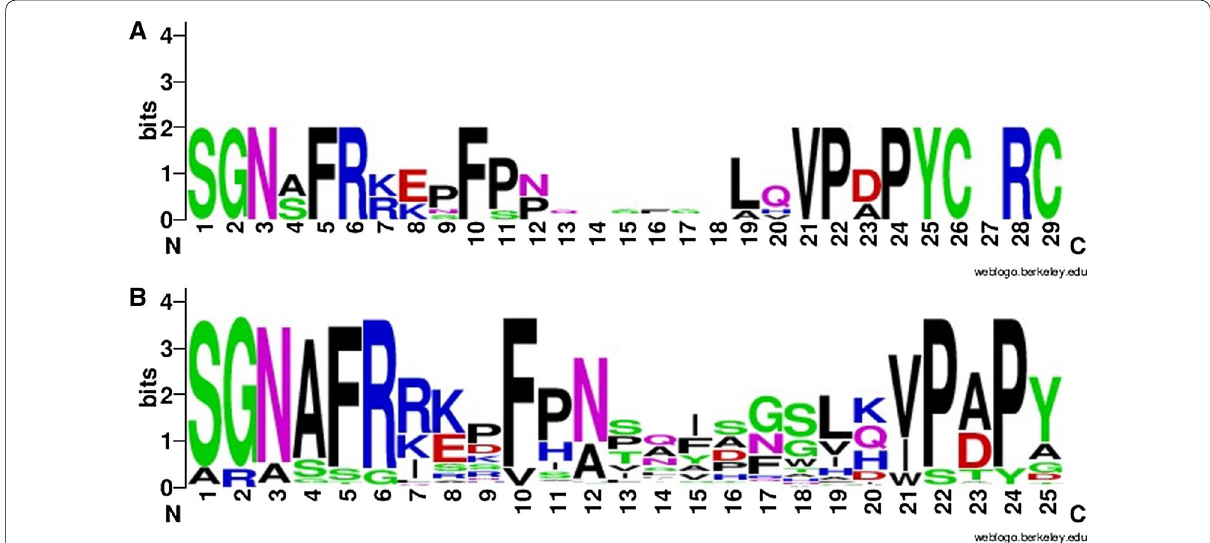
Fig. 6 A WebLogo sequence of all known azasugar producers (corresponding to amino acids 145–170 in B. velezensis FZB42). B WebLogo sequence of all known and putative azasugar producers (corresponding to amino acids 145–170 in B. velezensis